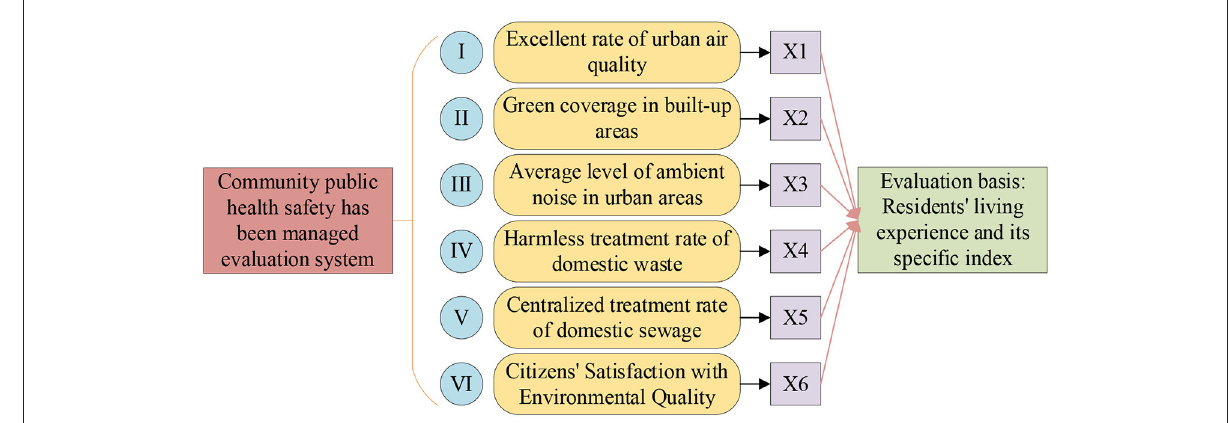
FIGURE2 Basic information on urban environmental health assessment.